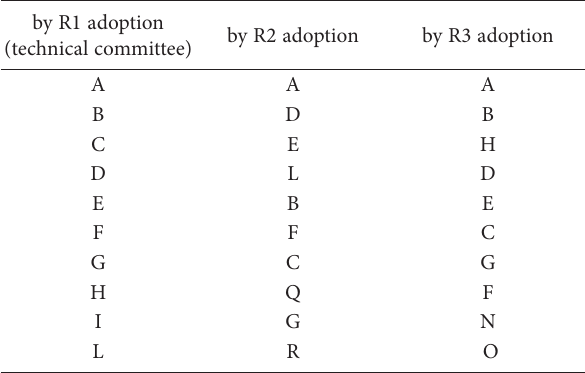
Table 6. The first 10 alternatives sorted by the summary indicator, obtained for R1 (the choices of the Technical Committee), R2, and R3 (the letters of the alphabet symbolize the alternatives, i.e. the